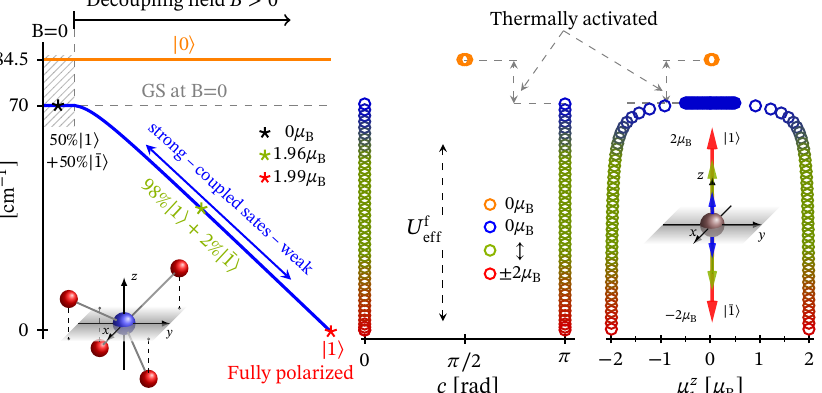
Figure 12. On the left panel, we show the evolution of the effective FSG as a function of the external magnetic field in the case of tetrahedral coordination along with the decoupling of the effective spin-one states | 1 (cid:105) and | ¯1 (cid:105) , coupled via spin–orbit interactions. The pathway to the state | ¯1 (cid:105) is a reflection taken with respect to the depicted energy axis. In the middle panel, we have the dependence of internal energy per single complex on the direction angle c taken between the principle axis and total magnetic moment expectation value. The calculation are performed at T = 0.05 K. Further details are given in Table 1. The dependence of U f on the z component of the ground state magnetic eff moment is shown on the right